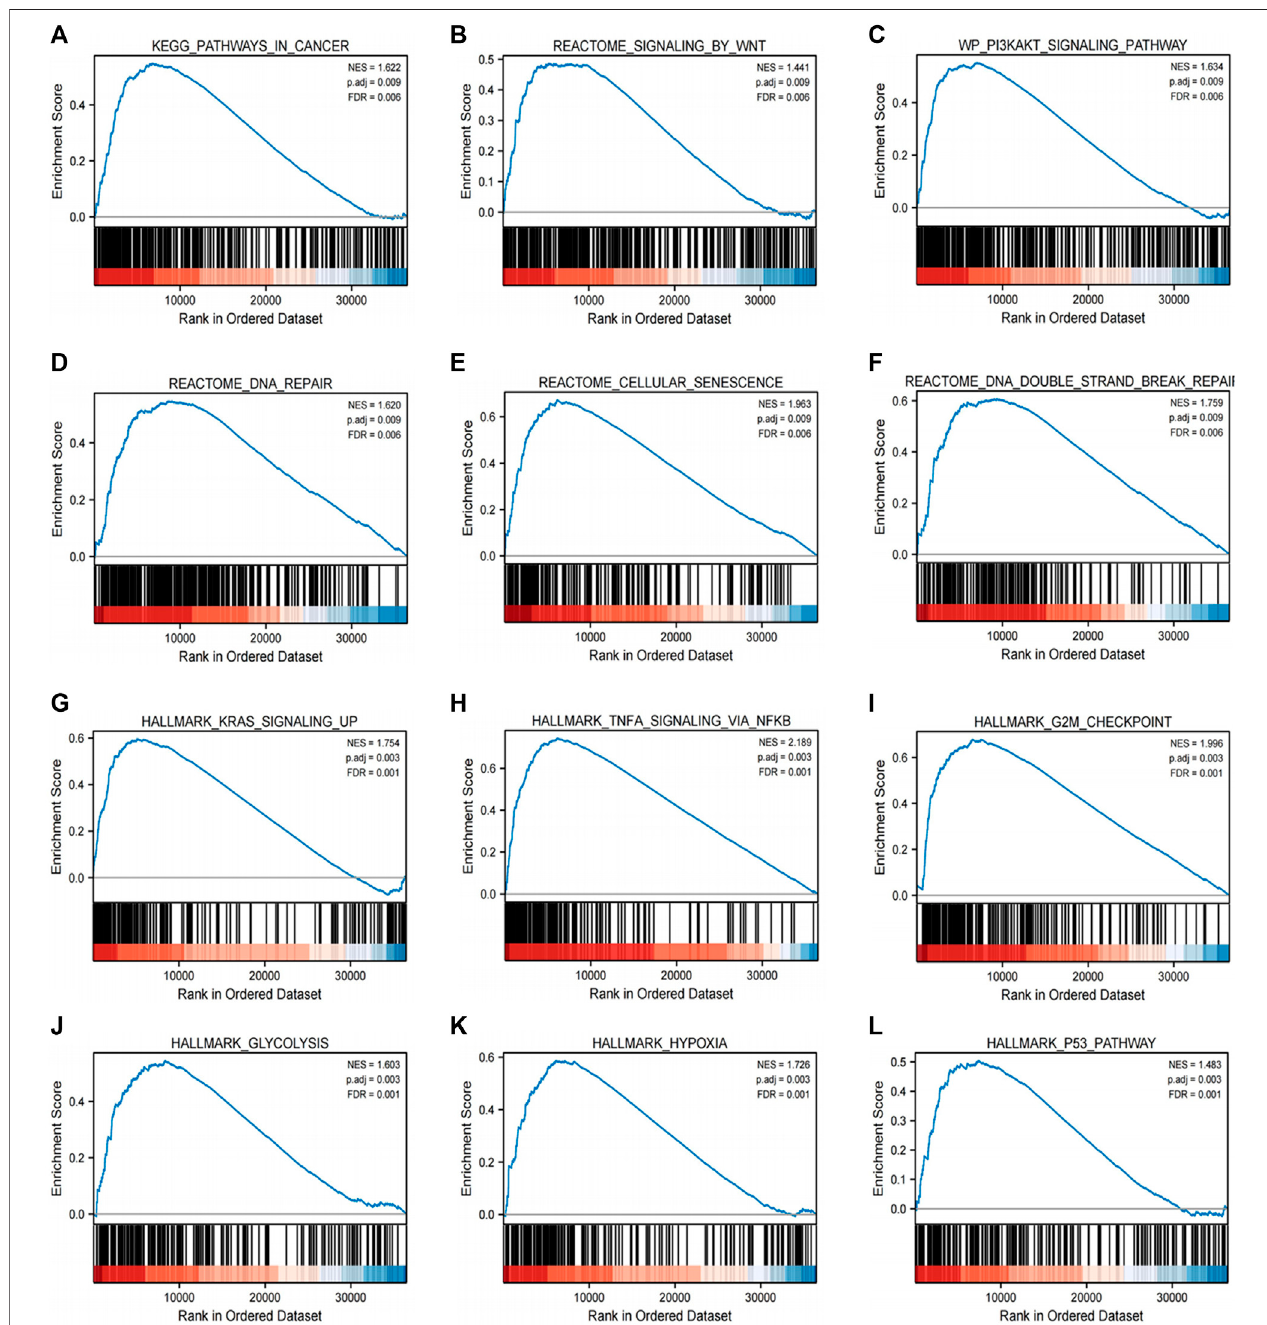
FIGURE5| EnrichmentplotsfromGSEA.GSEAresultsshowingpathwaysincancer (A) ,signalingbywnt (B) ,thePI3K-AKTsignalingpathway (C) ,DNArepair (D) , cellular senescence (E) , DNA double-strand break repair (F) , KRAS signaling up (G) , TNFA signaling via NFKB (H) , G2M checkpoint (I) , glycolysis (J) , hypoxia (K) , and the p53 pathway (L) , which are differentially enriched in H2BC12-high expression phenotype. NES, normalized ES; p. adj, p. adjust; FDR, False Discovery Rate.